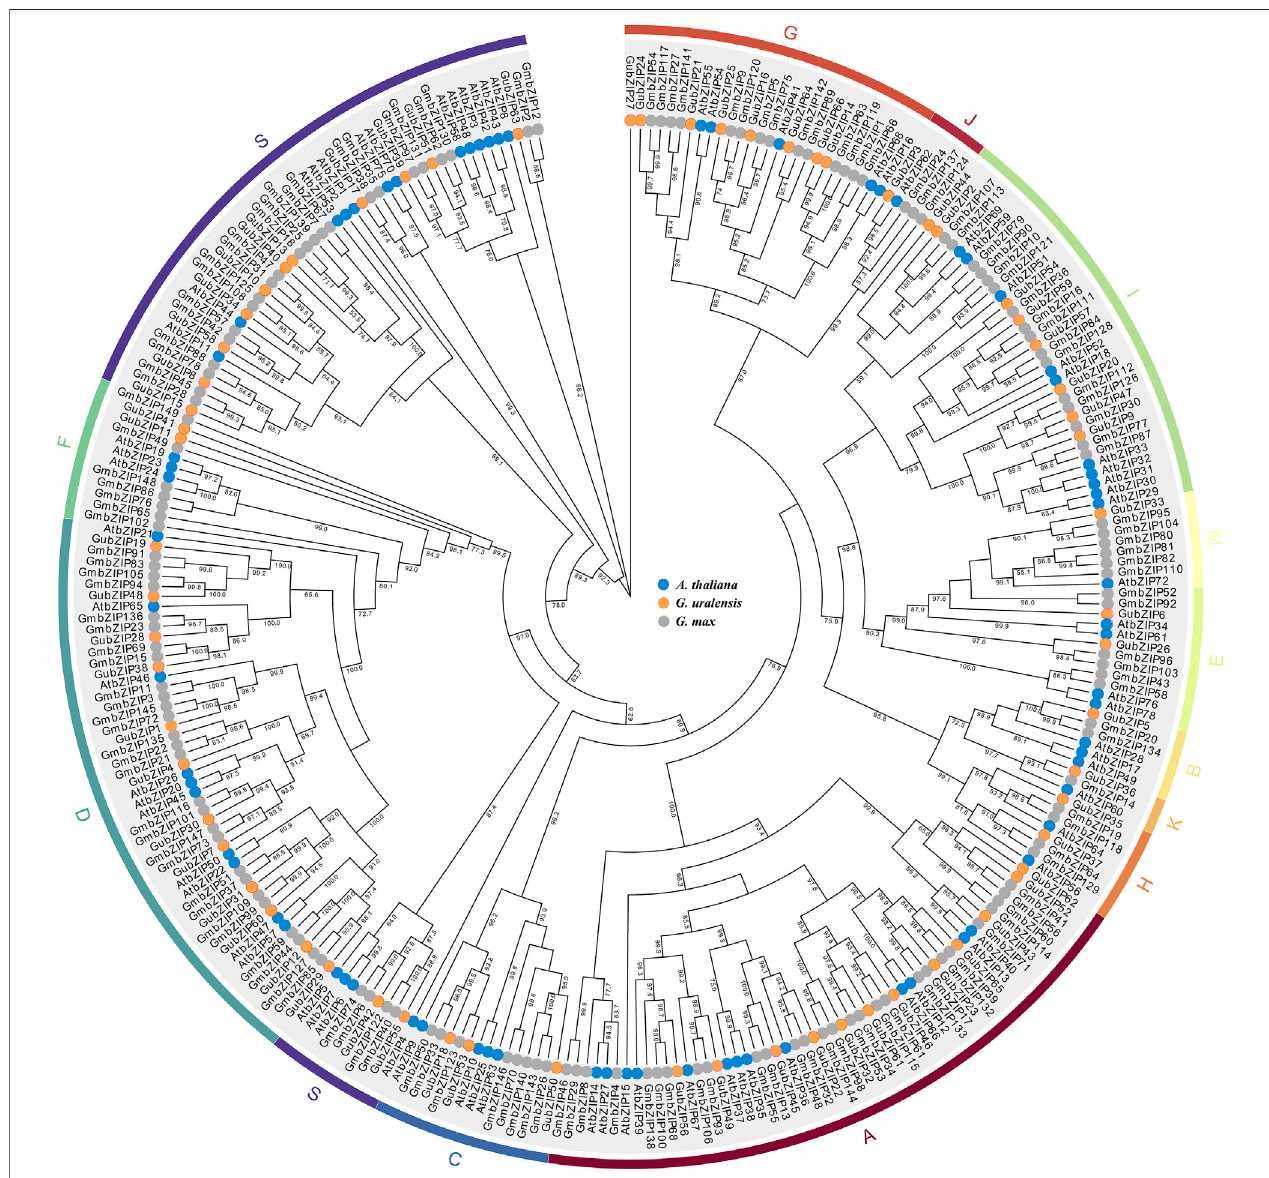
FIGURE 1 | Phylogenetic analysis of bZIP proteins in Arabidopsis thaliana , Glycine max , and Glycyrrhiza uralensis . Protein sequence alignment was carried out in MEGA X by ClustalW, and the evolutionary tree was constructed by maximum likelihood method through IQ-TREE. The pilot value is based on 1,000 duplicates. Only pilotvaluesgreaterthan50%aredisplayed.Theends ofbranchesfrom differentspecies arerepresentedbycirclesofdifferentcolors.ThebZIP protein isdividedinto13 different evolutionary branches (A – K, M, and S), which are marked by curves with different colors.